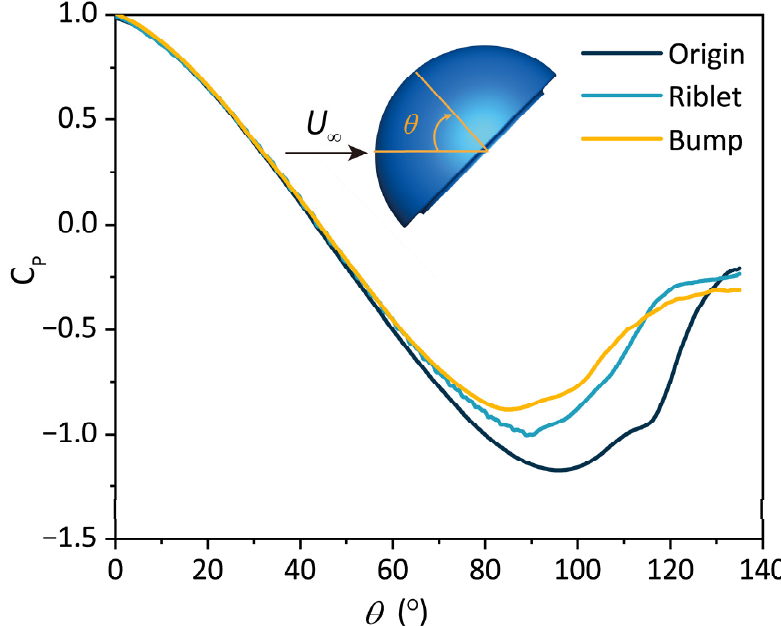
Figure 13. Pressure coefficient distribution on the midline of the CFD helmet surface.